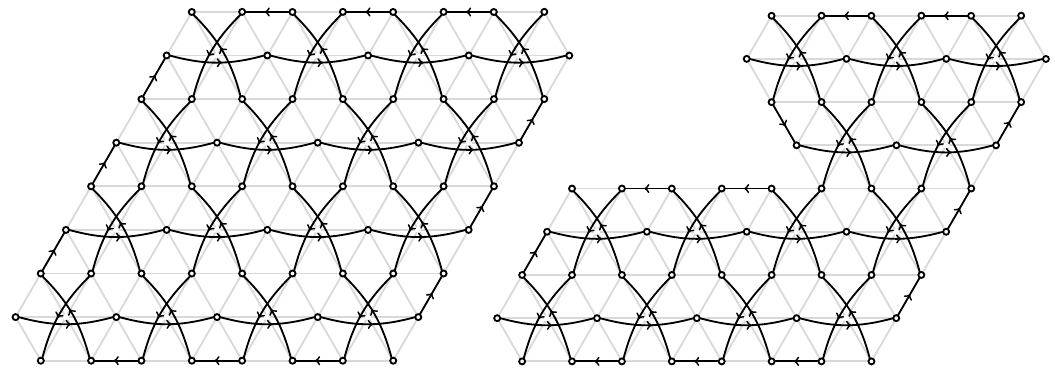
Figure 9 . Left: in the k = 4 × 4 parallelogram moose lattice with reflective boundary conditions, there are two sets of closed SU( N ) m loops, and three open lines with SU( N ) ‘ × SU( N ) r global symmetries. The open ended SU( N ) m − 1 theories confine, following ref. [5], while the closed loop SU( N ) m theories have Coulomb phases, as in ref. [4]. Right: here we show an asymmetric moose lattice with reflective boundaries and an arbitrarily chosen shape. In this example there are no closed loops: the gauge invariant Wilson lines transform under the SU( N ) ‘ × SU( N ) r global symmetries of the nodes on the corners of the